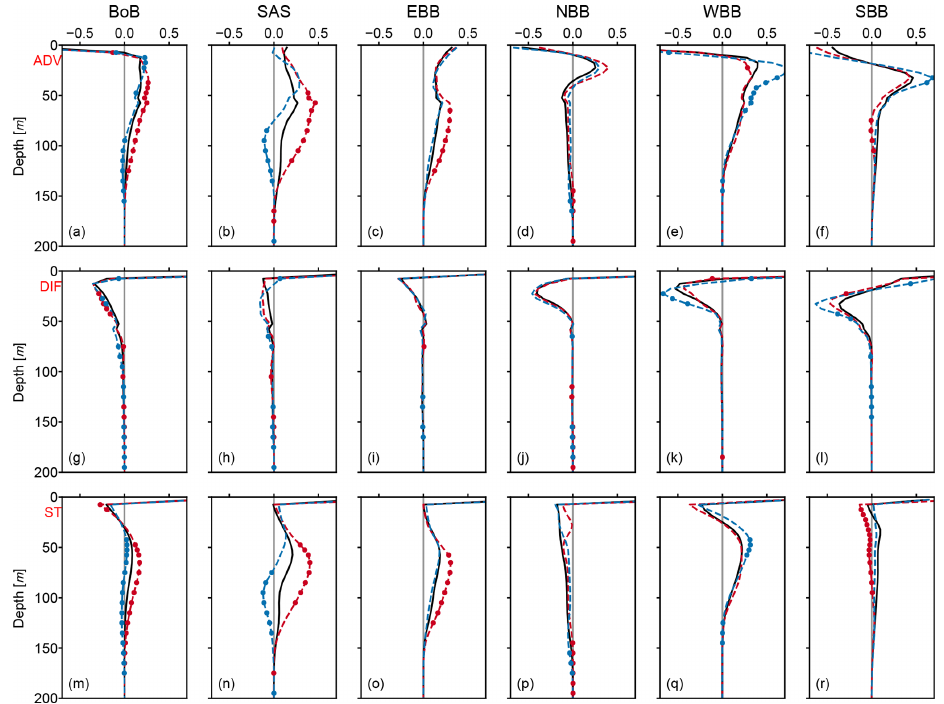
Figure 15. Sum of domain-averaged advection terms (in psu per month) at different depths of the BoB (a) and its subareas (b, c, d, e, f) during ASO. The solid black line is for the climatology, and the dashed red and blue lines are for the composite of pIOD and nIOD years, respectively. Dots with corresponding color indicate that they are significantly different at the 95% confidence level using a two-tailed Welch’s t test compared to the climatology. The second and third row are the same as the first row but for sum of domain-averaged diffusion terms and salinity tendency,